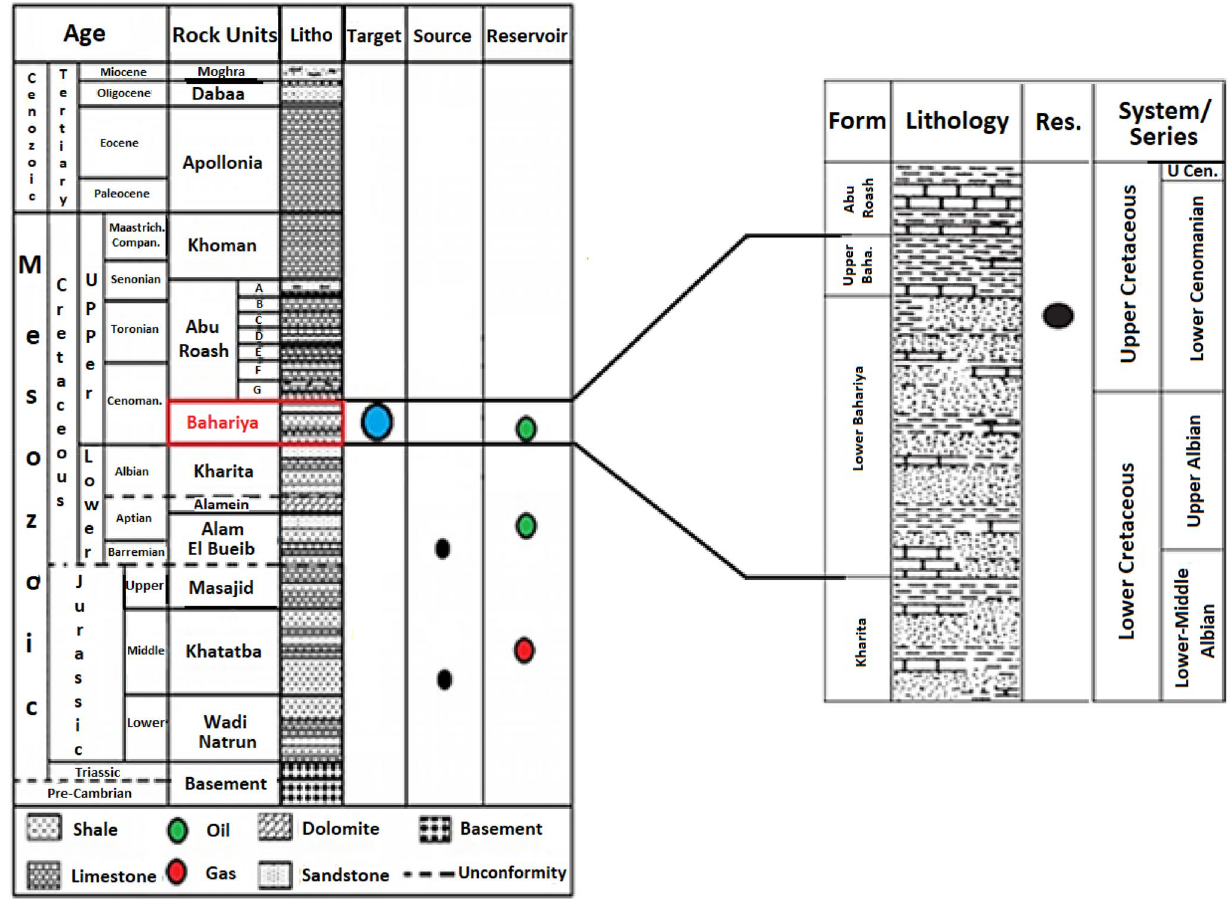
Fig. 2 A generalized stratigraphic column of the Khalda Oil Field in the Western Desert with a detailed sketch for the Bahariya Formation (Schlumberger